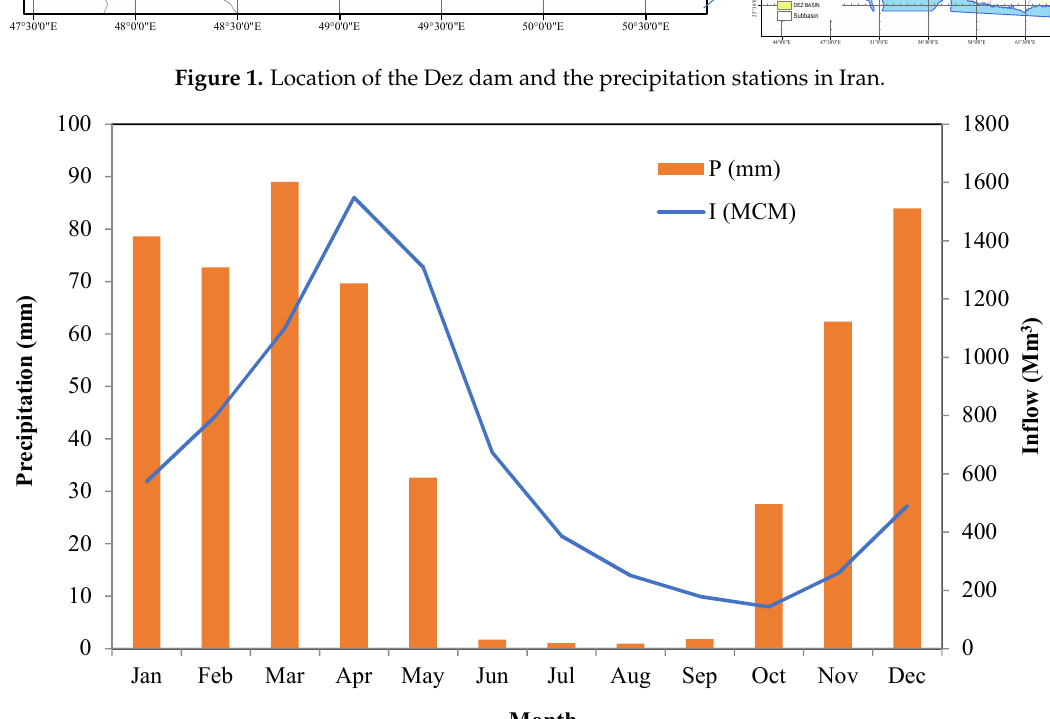
Figure 2. Average monthly precipitation in the catchment and mean monthly inflow to the Dez dam reservoir.